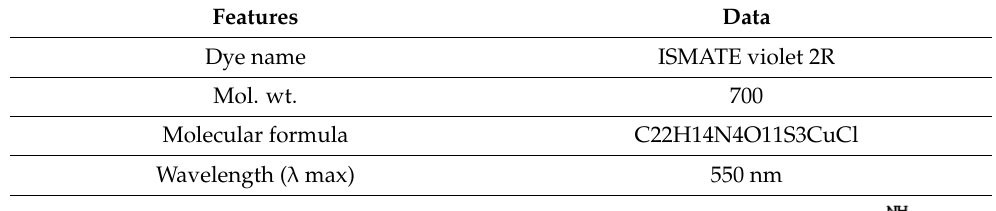
Table 1. The chemical and physical properties of the ISMATE 2R dye [2].